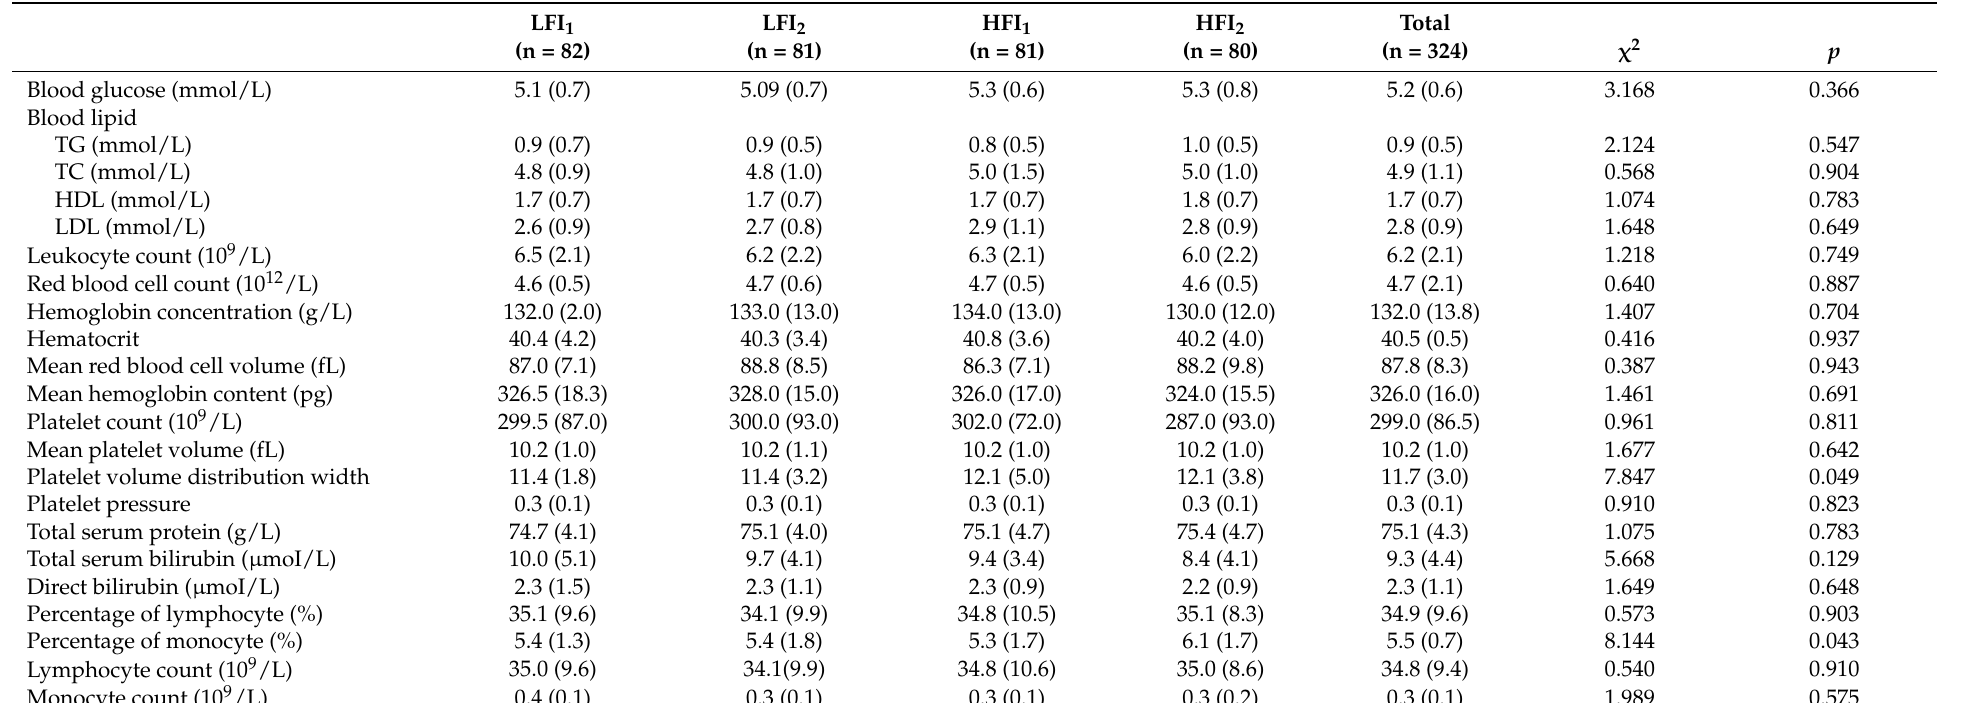
Table 5. Blood indexes of participants with different TFI